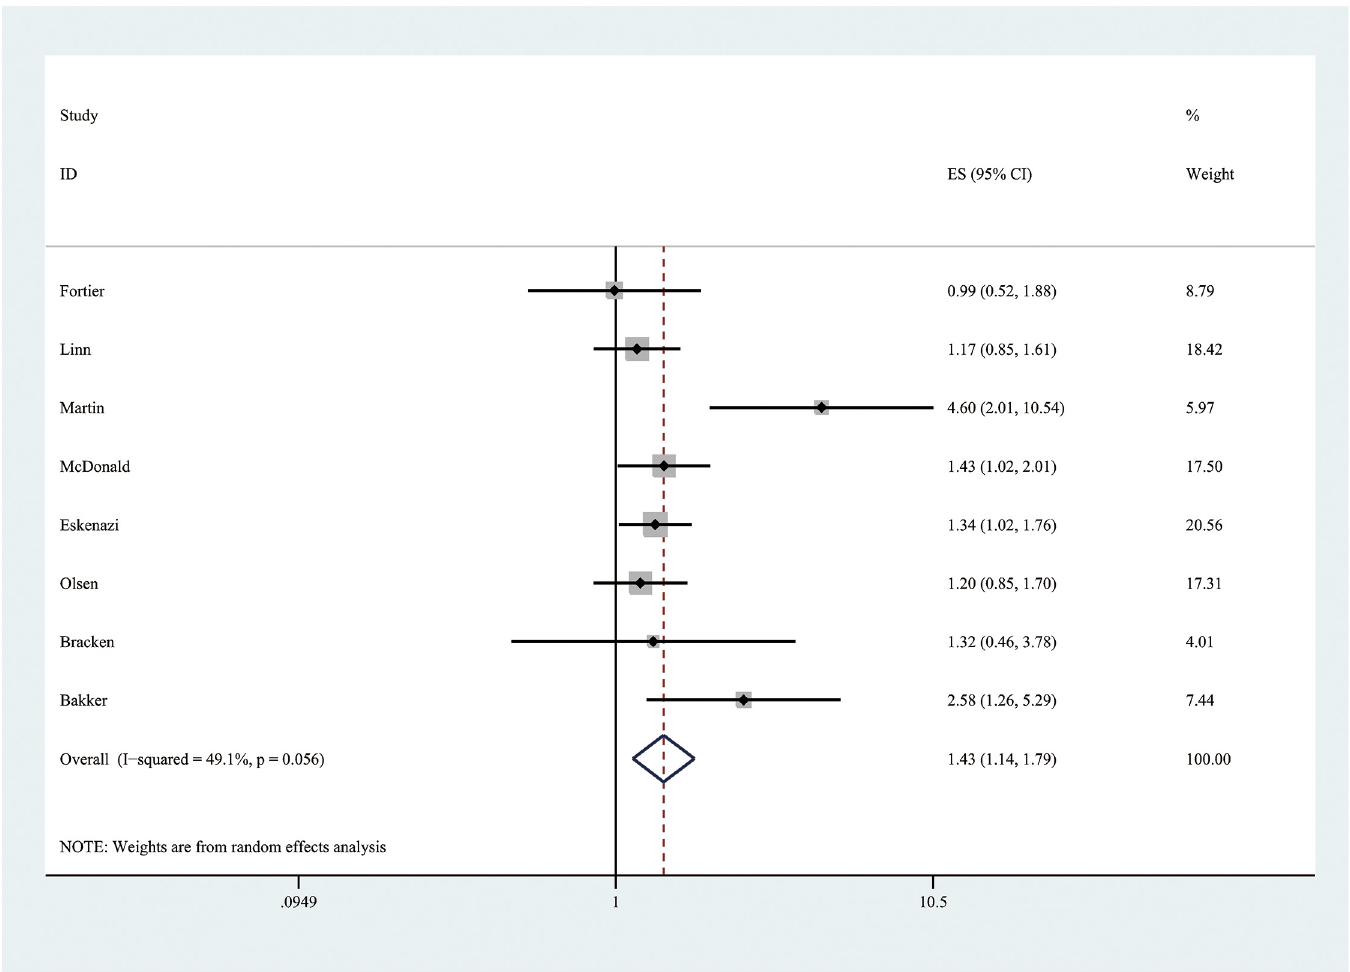
Fig 3. Forest plot of meta-analysis by using random effects model for the effect of maternal caffeine intake during pregnancy on the risk of low birth weight (comparing highest versus lowest levels) among cohort studies.